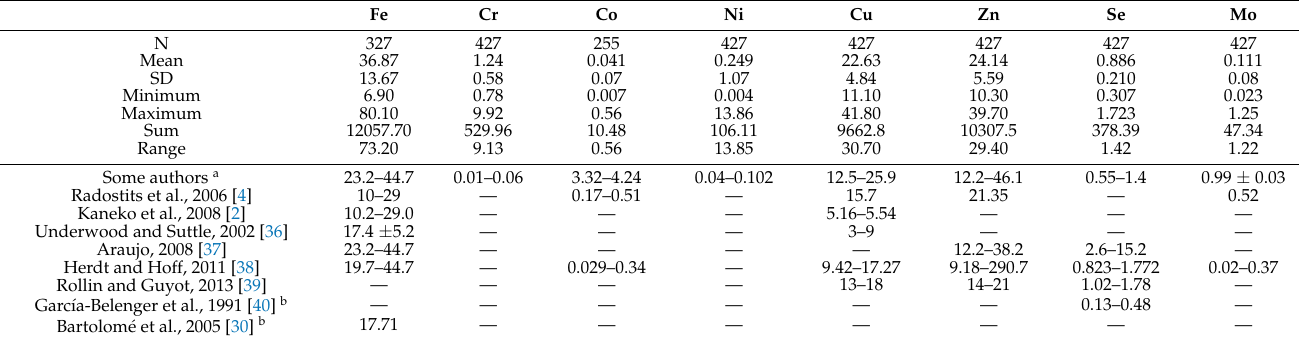
made the SD (13.67) and the interquartile ranges reach greater values of all the microminer- als (Table 2 and Figure 3). Chromium, copper and nickel mean concentrations were greater than basal values reported in literature, and the SD of the last two trace elements (4.84 and 5.59) reflects the differences between the minimum and maximum values found (Table 2). Table 2. Mineral values (trace elements) in bull plasma after intense exercise: descriptive statistics. Values indicated by other authors are also showed.